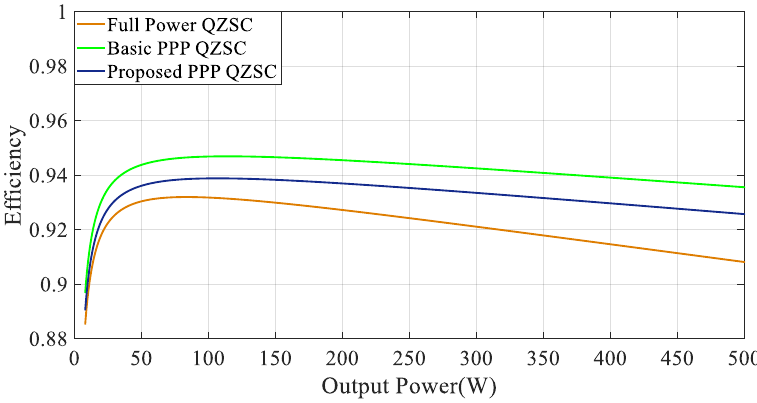
ffi ciency versus output power for the three discussed converters. Figure 11. Efficiency versus output power for the three discussed converters . Figure 11. E Figure 11. Efficiency versus output power for the three discussed converters . Figure 11. Efficiency versus output power for the three discussed converters .